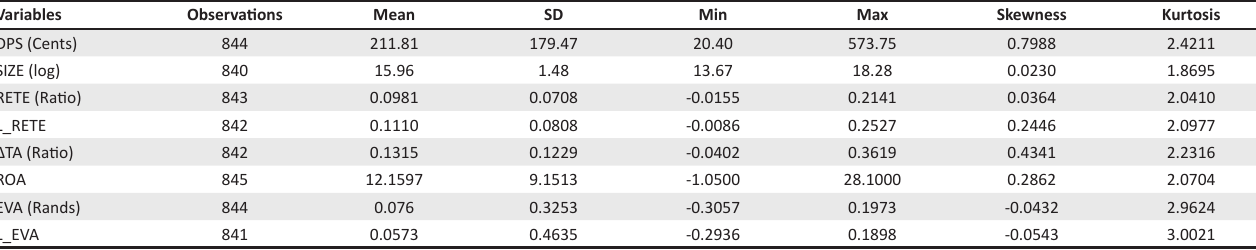
TABLE 5: Descriptive statistics for all variables of Panel 2: Value companies. Variables